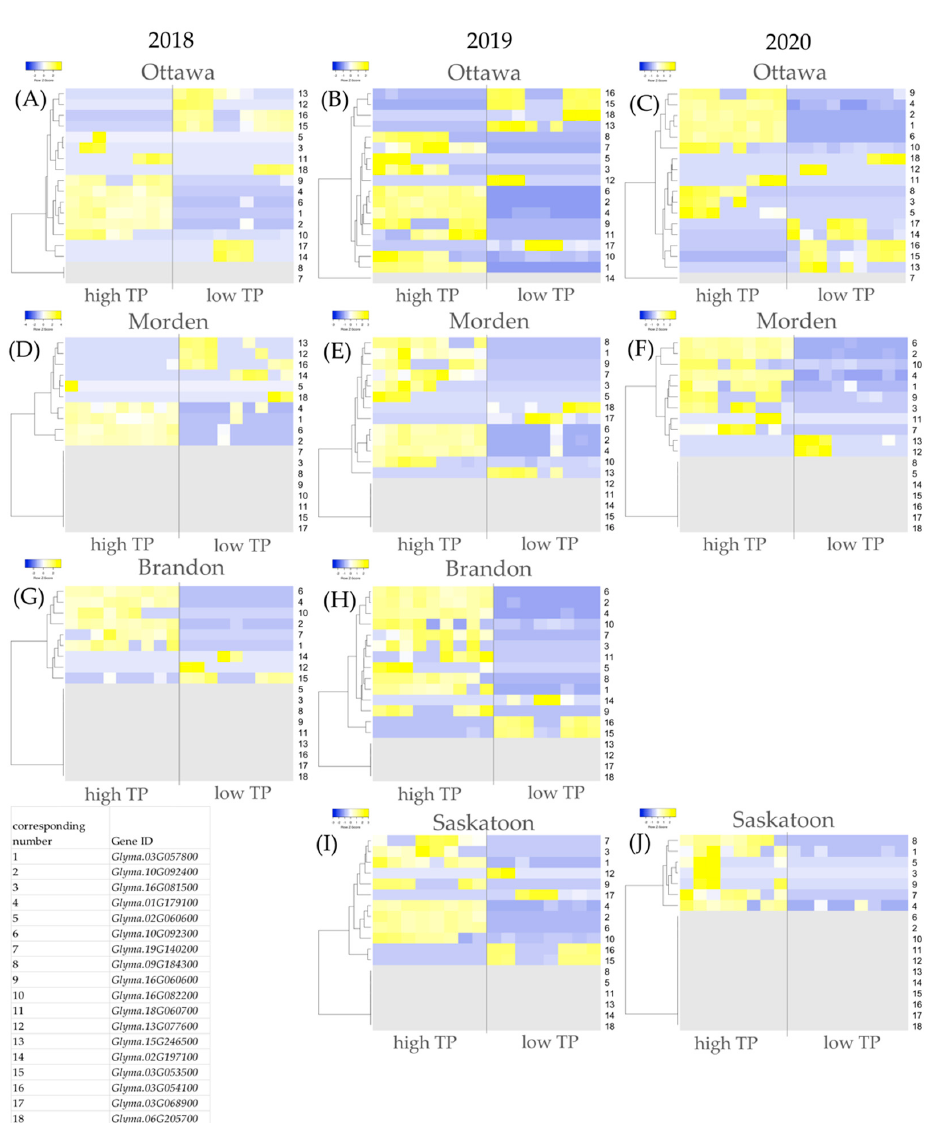
Figure 4. Expression heatmaps for shortlisted genes differentially expressed in high TP soybeans (lines 8, 9, 10 vs. lines 1, 2, 3) for each year-location analysis. Each TP year-location dataset is represented: ( A ) Ottawa 2018, ( B ) Ottawa 2019, ( C ) Ottawa 2020, ( D ) Morden 2018, ( E ) Morden 2019, ( F ) Morden 2020, ( G ) Brandon 2018, ( H ) Brandon 2019, ( I ) Saskatoon 2019, ( J ) Saskatoon 2020. Upregulation is indicated by shades of yellow, downregulation is indicated by shades of blue. Grey indicates that a gene was not differentially expressed between high and low TP soybeans at an adjusted p -value < 0.05. The legend at the bottom left provides the gene identities and their correspondence with the numbers on the right y-axis of the heatmaps.